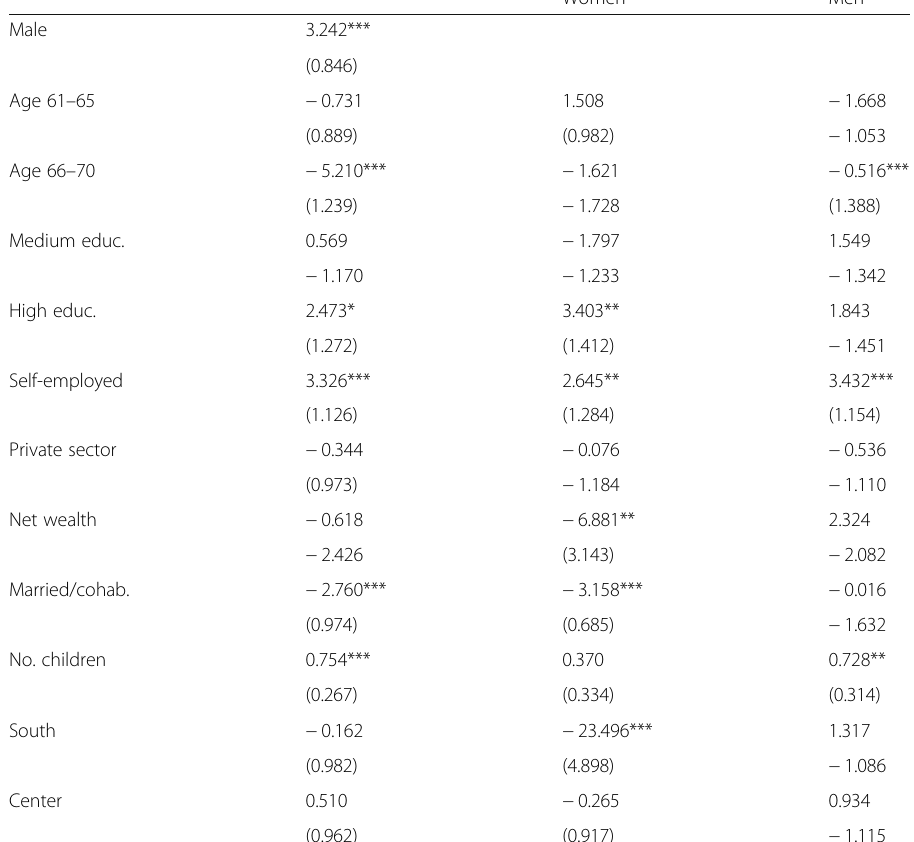
Table 5 Desired working hours (Tobit),